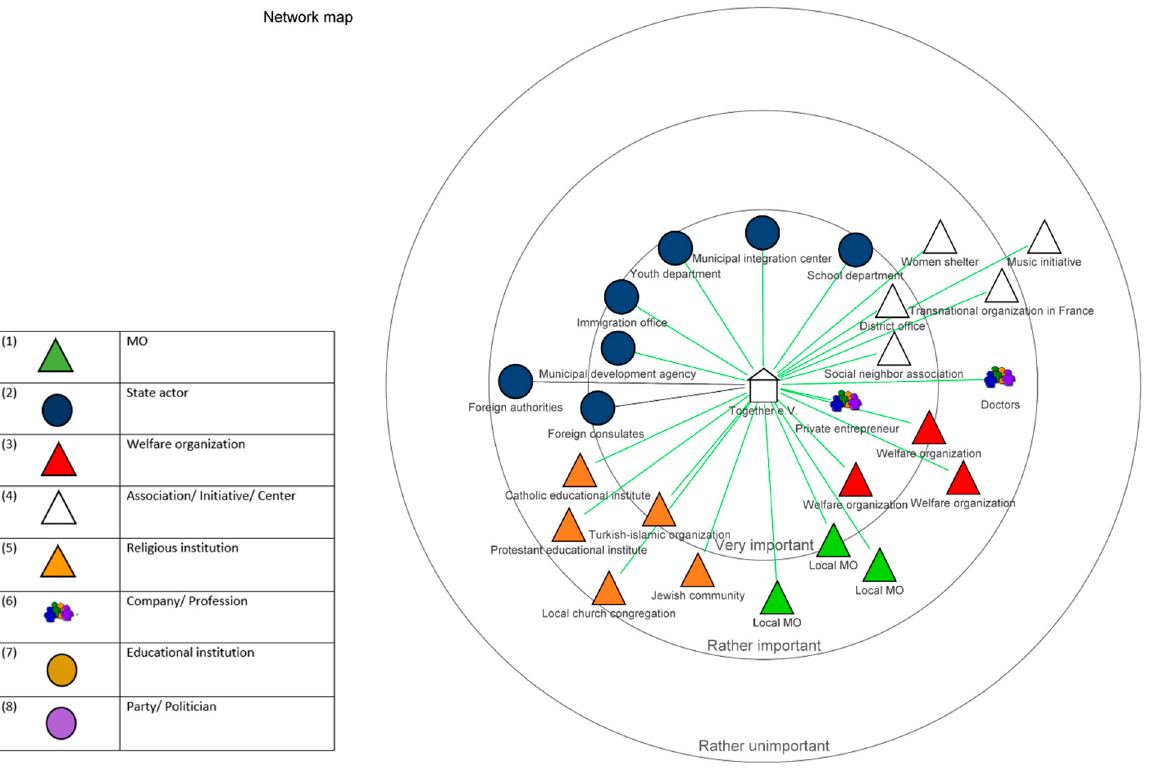
Figure 3. Network map of Together e.V.